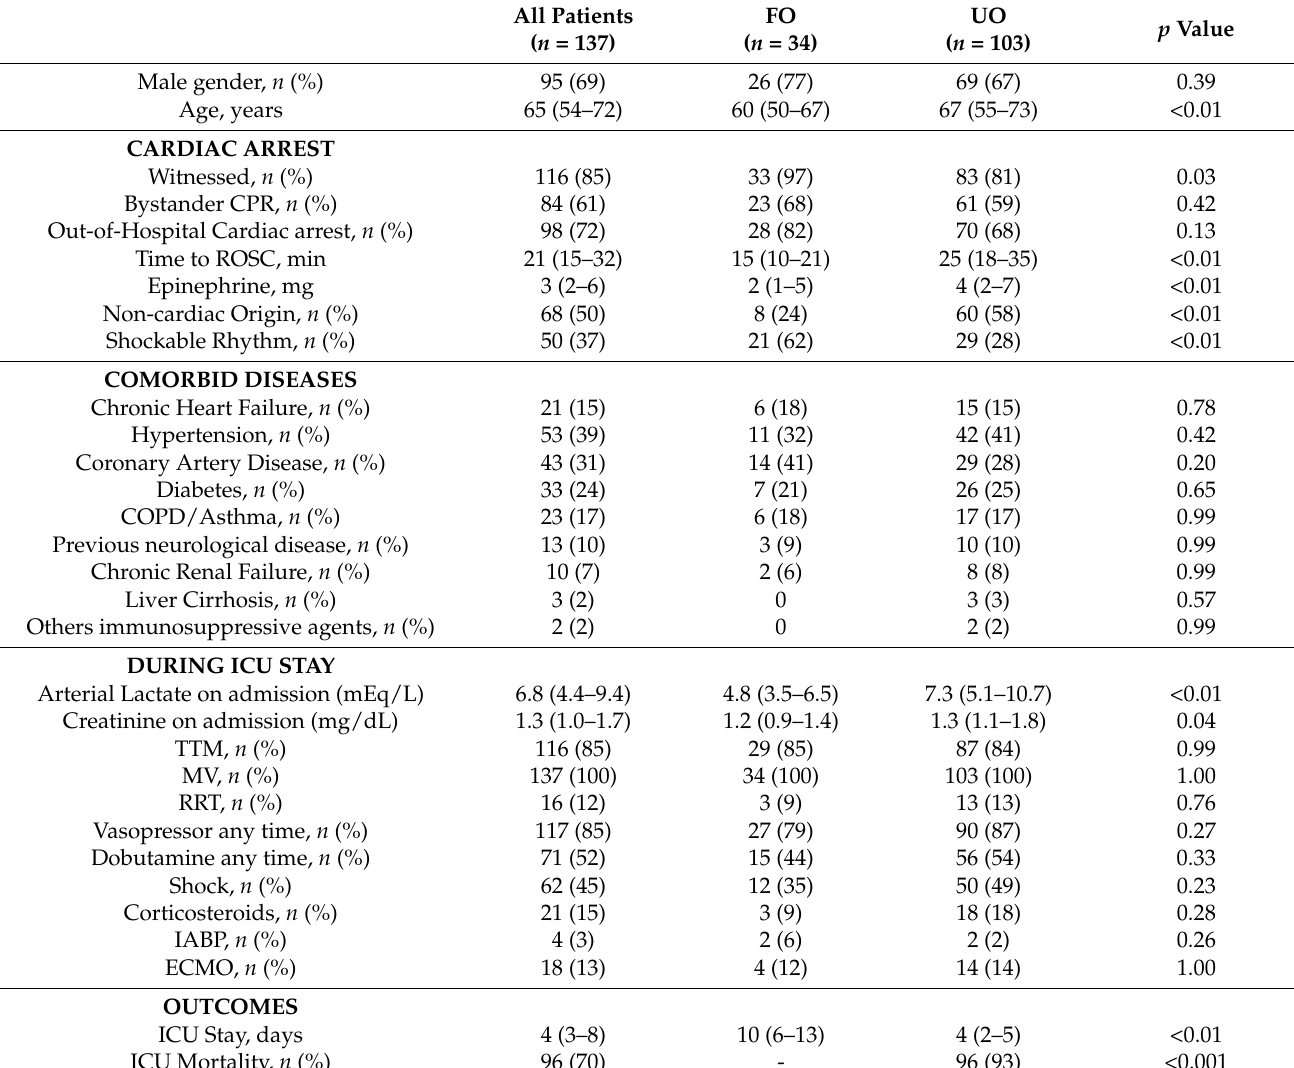
Table 1. Clinical characteristics of the study population according to the neurological outcome (FO = favourable; UO =